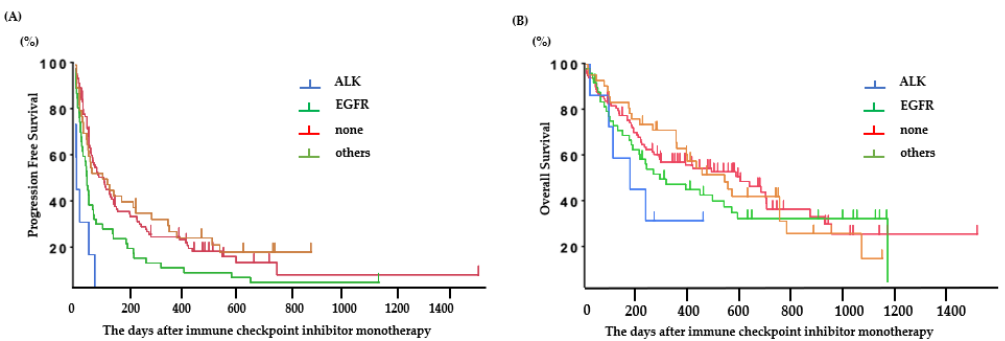
Figure 1. Clinical outcomes and PD-L1 expression in patients treated with ICI. ( A ) Progression-free survival and ( B ) overall survival (N = 190). ( C ) PD-L1 status according to oncogenic subtypes in patients assessed for PD-L1 expression (N = 151). Underlined values indicate a significant difference.